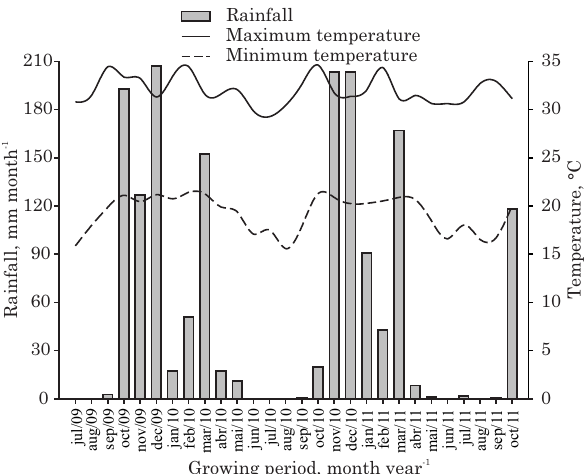
Figure 1. Rainfall, monthly maximum and minimum temperature obtained in the municipality of Janaúba, MG, Brazil, for the growing period of the ‘Vitória’ pineapple plant (07/2009 to